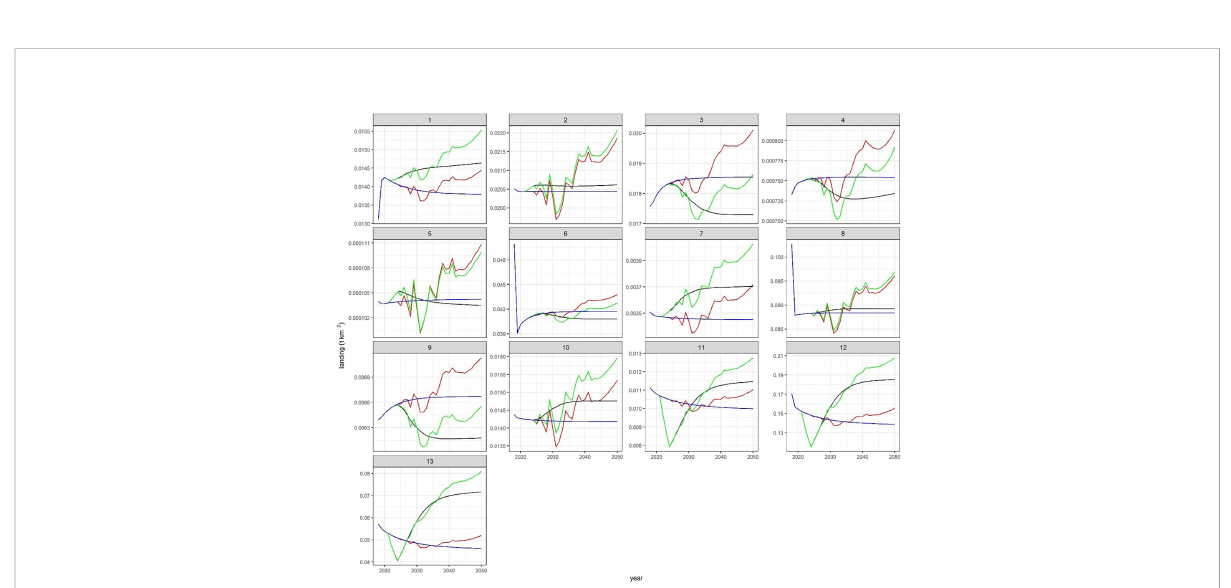
FIGURE 4 Trends of landings per fl eet across reference (REF) and alternative scenarios (F,C,FC). Fleet: 1 = 1LL, 2 = 1GN, 3 = 1PS, 4 = 1.2MIS, 5 = 1.2FPO, 6 = 2LL, 7 = 2GN, 8 = 2.3PS, 9 = 2.3OTM, 10 = 2PTM, 11 = 1OTB, 12 = 2OTB, 13 = 3OTB. REF = blue, F = black, C = red, FC =